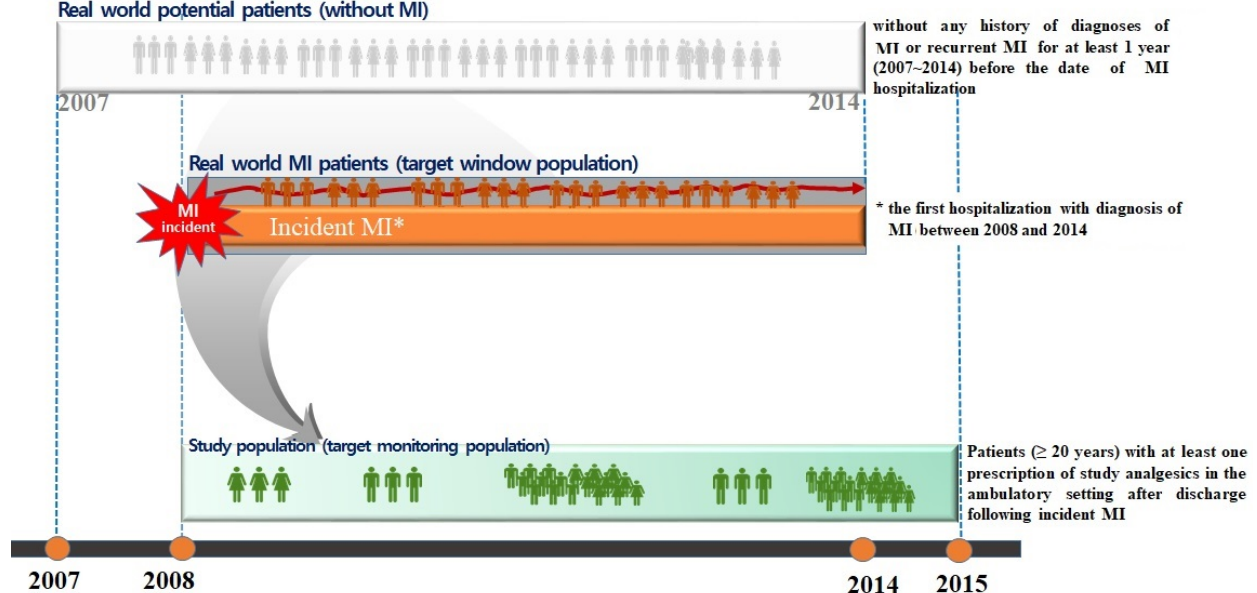
Figure 1. Graphical depiction of the study design.